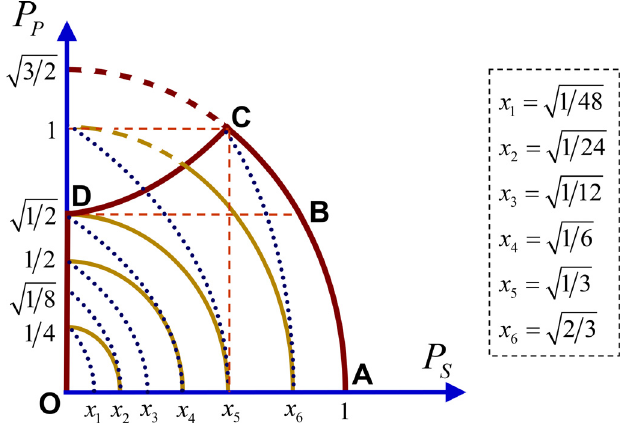
Figure 2. Purity figure, where the solid elliptical branches represent iso-purity Mueller matrices ( P Δ constant), and the dashed elliptical branches represent iso-specific-reversibility ( R S constant) Mueller matrices. Descriptors P S , P ∆ , and R S coincide along axis P S , while the difference R S − P ∆ increases as P P increases. The feasible region is limited by points OACD. Points O, A, and C represent, respectively, perfect depolarizers, retarders, and perfect polarizers. The maximal achievable value of P P for media with P S = 0 corresponds to point D, while points over the line BD necessarily exhibit P S > 0